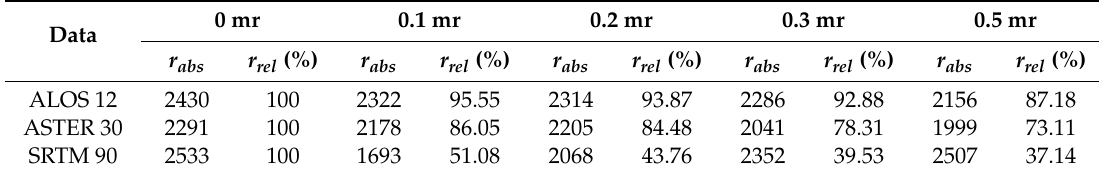
Table 3. Repeatability of keypoints with di ff erent levels of noise.